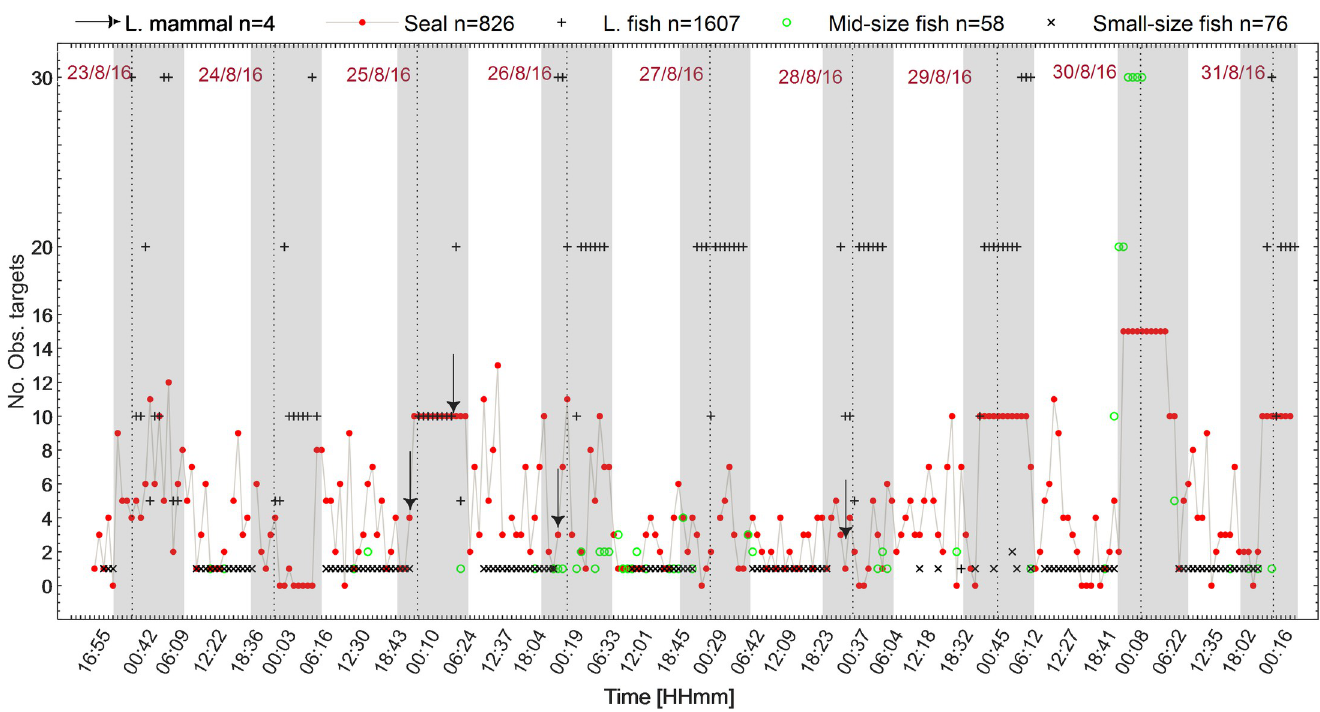
Fig 11. Time series of the observed targets starting from the time of deployment (23-08-2016) until the time of retrieval (01-09-2016). Small and mid-size fish were observed and counted in schools. The occurrence of small-size and large fish had diurnal and nocturnal patterns, respectively. Seals occurred with a random trend along the time. The grey shaded areas represent the